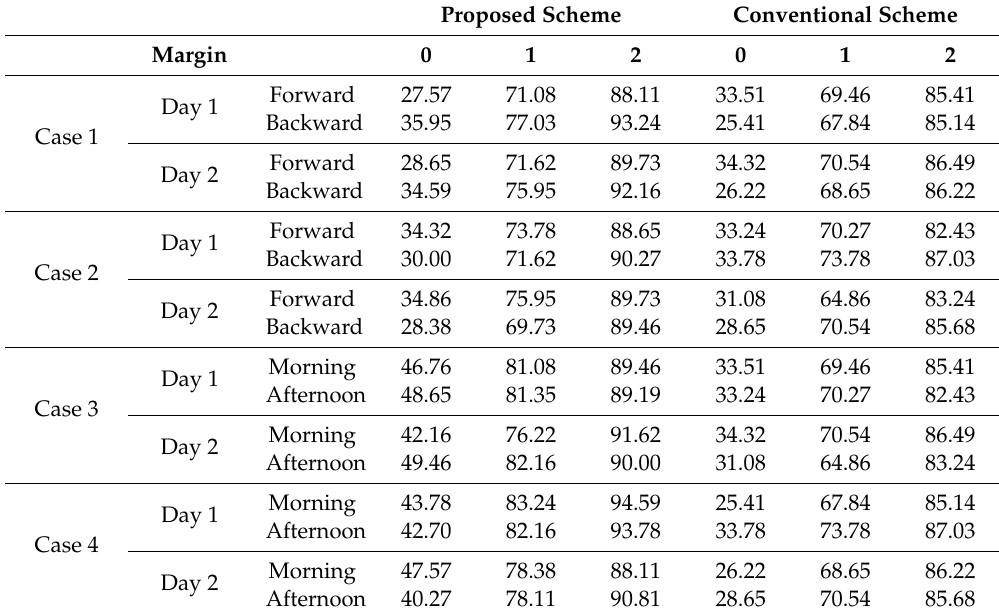
Table 6. Summary of experimental results (%).